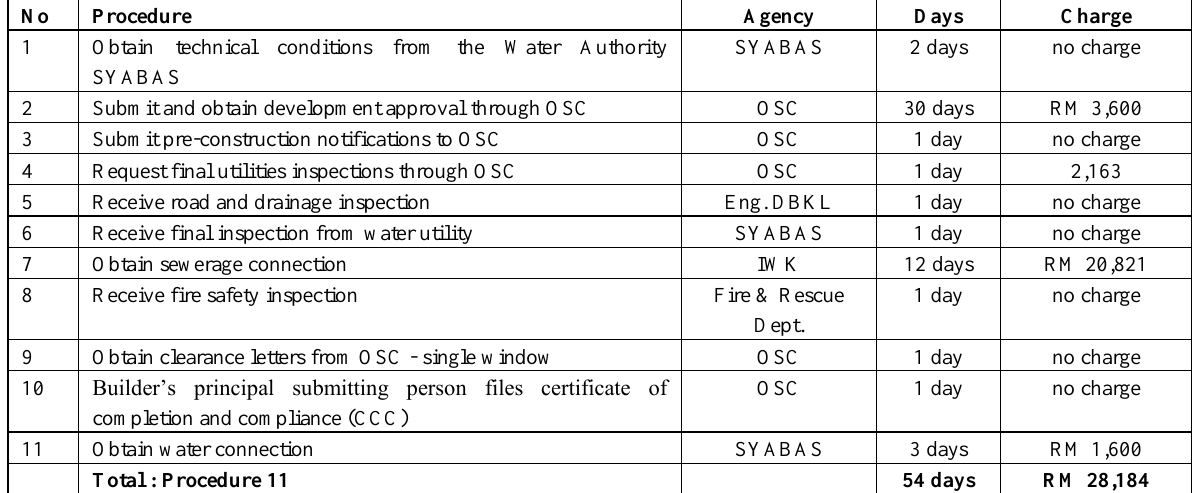
Table 1: Number of procedures, involvement from related agencies, and time/cost involve for a development project at RM2 million. Agency Days